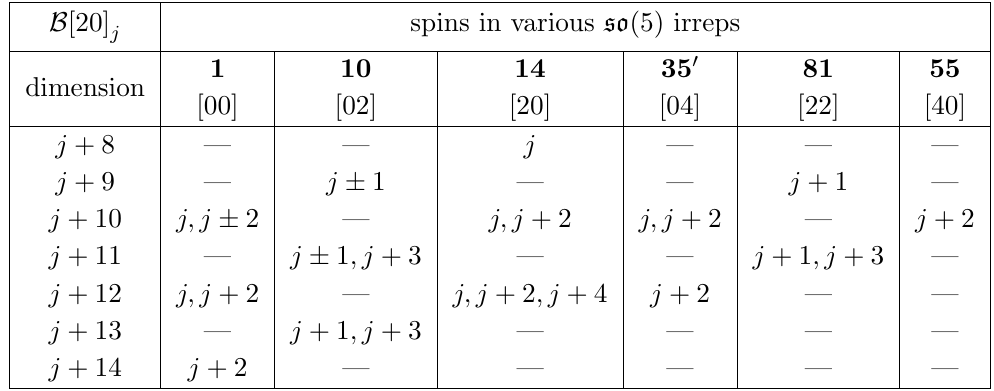
Table 7 . All possible conformal primaries in D [20] (cid:2) D [20] corresponding to the B [20] formal